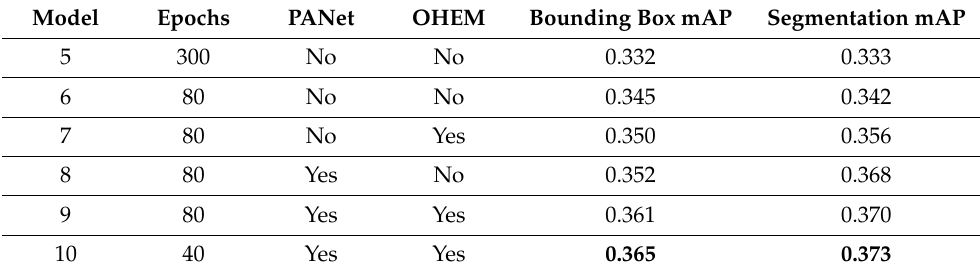
Table 5. Comparison of the test results using modified models based on the Mask R-CNN model-5.